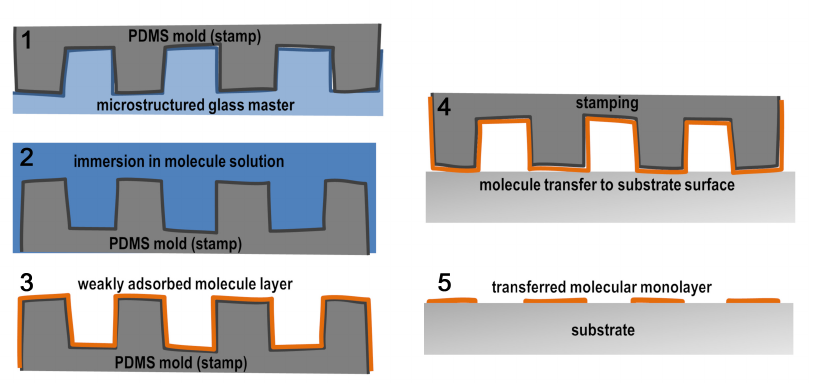
Figure 1. Cross section view of the µ CP-Process scheme. 1. Production of micro-structured PDMS- stamps by pouring Sylgard 184 elastomer on glass masters. 2.&3. Immersion of stamp in molecule solution for 24h. Molecules weakly adsorb onto PDMS stamp. 4.&5. Transfer of molecular monolay- ers by pressing the PDMS stamp on the glass